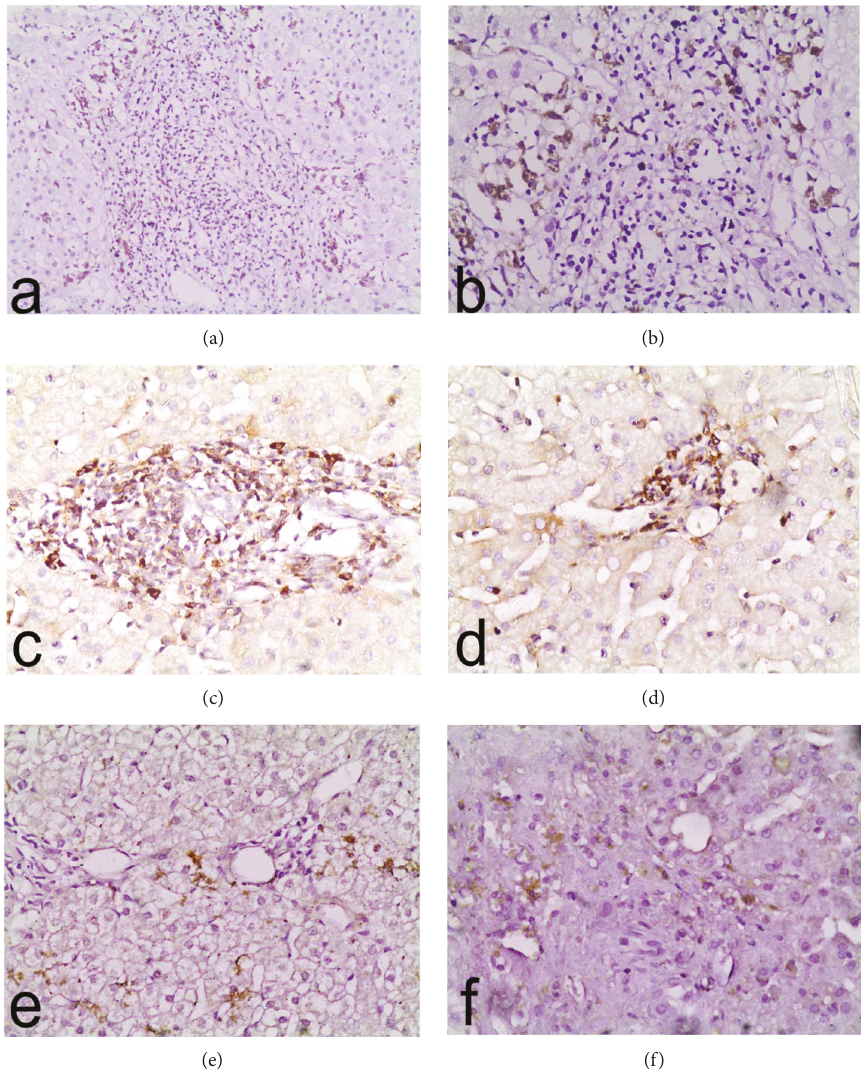
Figure 1: Immunohistochemistry of liver tissue postliver transplantation in recurrent hepatitis C (a, c, and e) and acute cellular rejection (b, d, and f) showing immunoreaction for CD68 (a and b), CD11b (c and d), and CXCR3 (e and f). Original magni fi cation × 200. Table 4: Comparison between recurrent chronic hepatitis C (CHC) and acute cellular rejection (ACR) regarding the studied markers (CD68, CD11b, and CXCR3) in absence of HCC. Marker